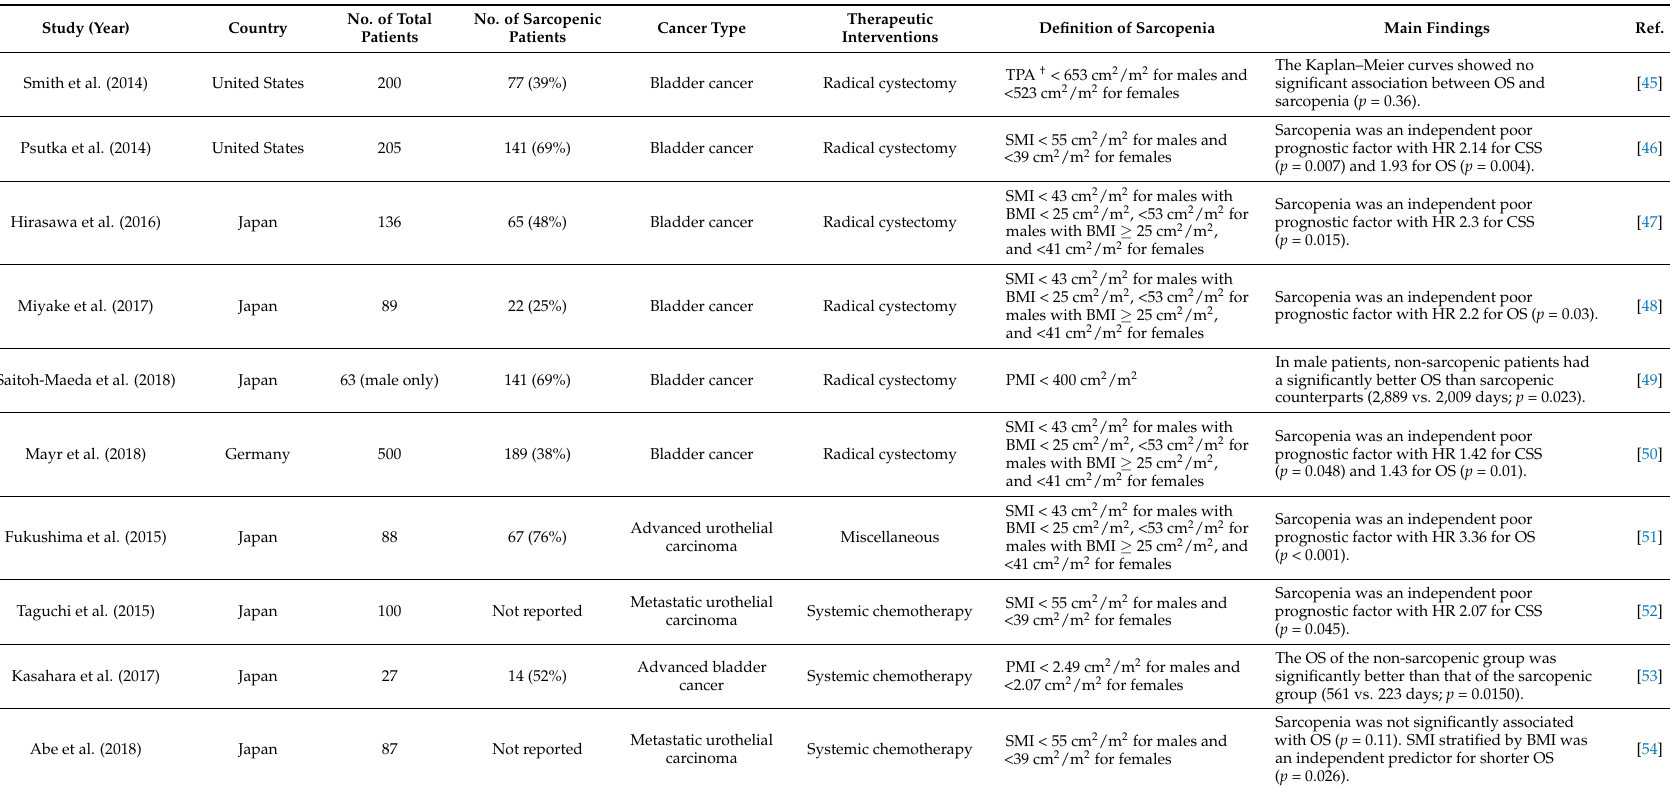
Table 1. Reported series of the prognostic role of sarcopenia in bladder cancer